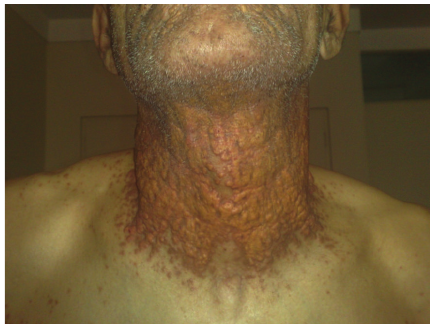
Figure 6: Dense dermal diffuse histiocytic infiltration.